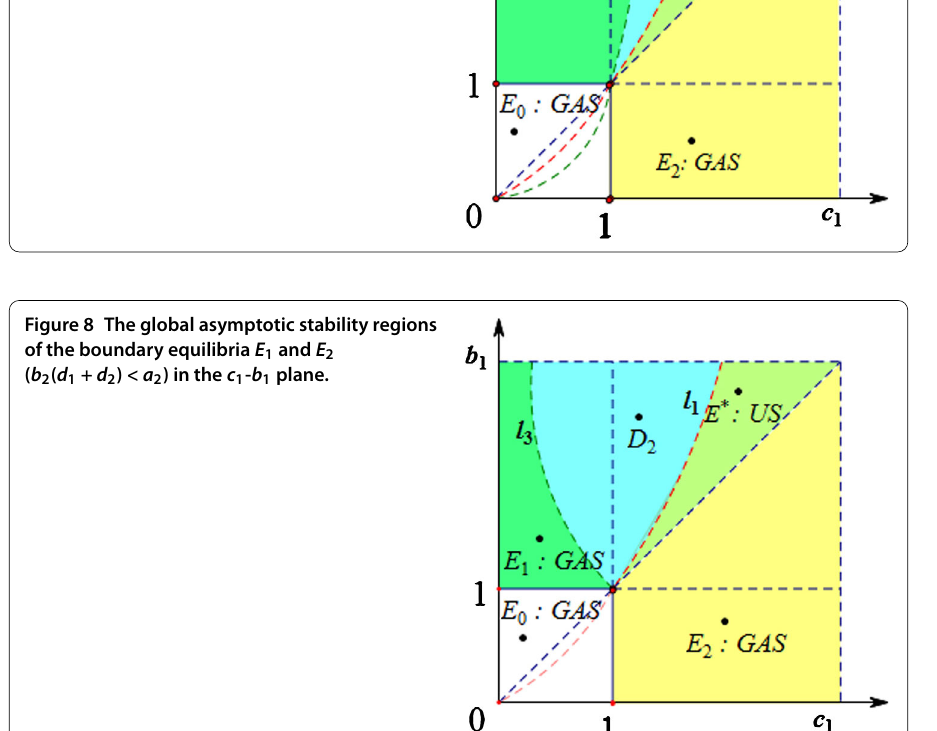
Figure 8 The global asymptotic stability regions of the boundary equilibria E 1 and E